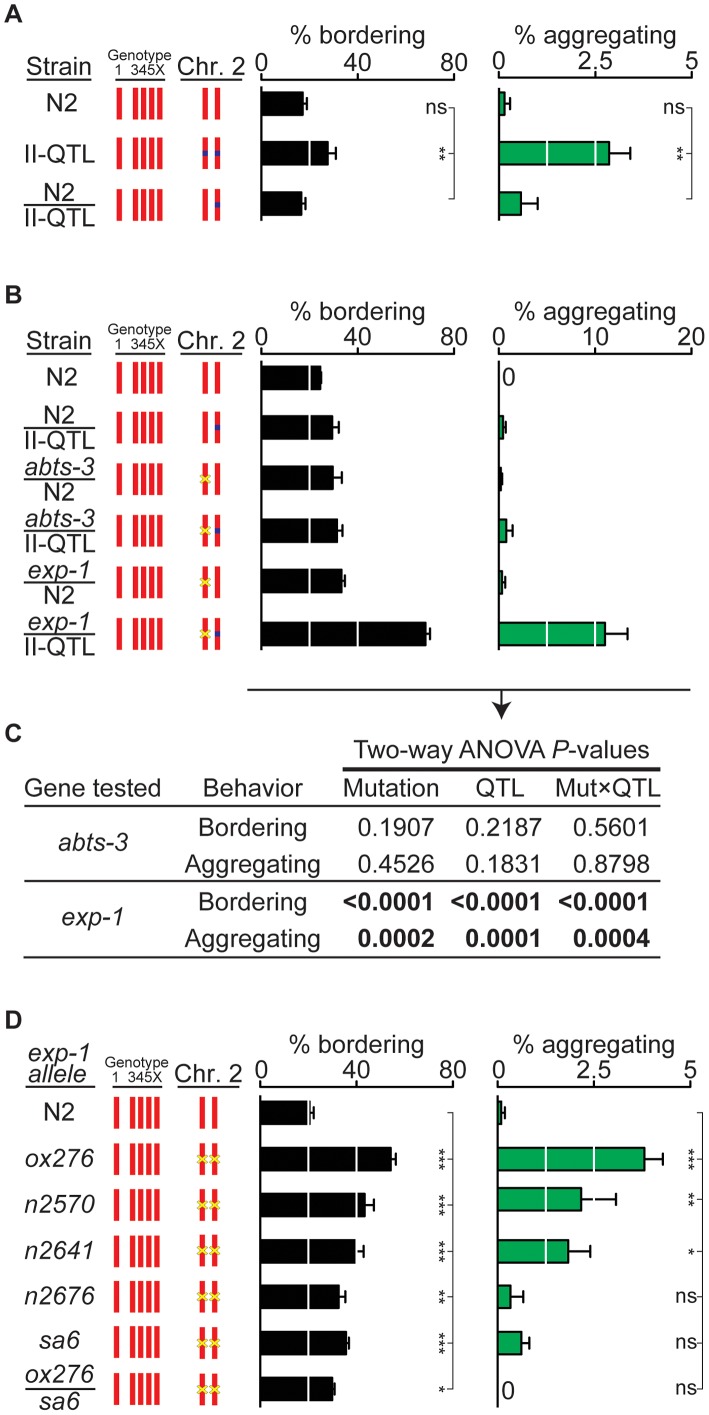

exp-1 is a quantitative trait gene for bordering and aggregation.(A) Dominance test between N2 and the II-QTL (n = 7). (B) Quantitative complementation tests between the HW II-QTL, N2, and deletion mutants abts-3(ok368) and exp-1(ox276). Heterozygote F1 progeny from crosses were identified using a fluorescent marker (n = 6 assays for each cross). Yellow ‘x’ denotes a deletion mutation. A transgenic fluorescent marker used to identify F1s in this cross elevated bordering slightly and may also accentuate aggregation (see Figure S4). (C) Analysis of variance of data in panel (B). Two-way ANOVA used Mutation (N2 vs mutant allele) and QTL (N2 vs II-QTL) as variables and was performed for both abts-3(ok368) and exp-1(ox276) mutations. A significant P value for the Mut×QTL interaction indicates failure to complement, a defining feature of quantitative trait genes [1], [39]. (D) Behaviors of exp-1(ox276), a deletion allele, exp-1(n2570), exp-1(n2641), exp-1(n2676), and exp-1(sa6) missense alleles, and exp-1(ox276)/exp-1(sa6) trans-heterozygotes. Yellow ‘x’ denotes a mutation. Error bars, s.e.m. In (A) and (D), * P<0.05, ** P<0.01, *** P<0.001 by ANOVA with Dunnett test. ns, not significant.